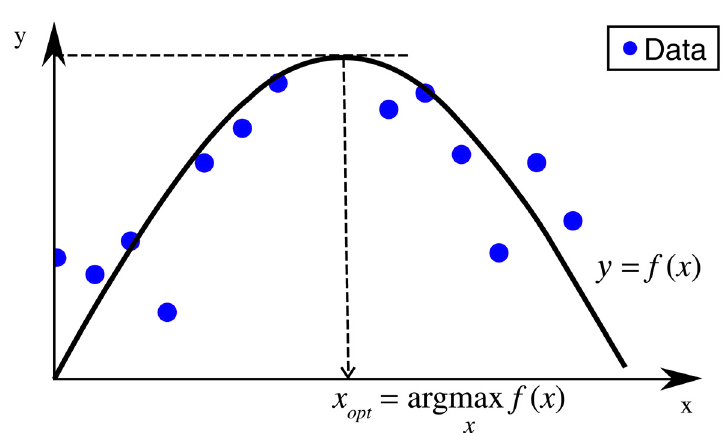
Figure 1. Optimization concept. A regression function f( x ) fits training data to determine new coordinates in descriptor space. Optimized coordinates based on f( x ) fall inside the training data range but yield a higher y value than any other data point.